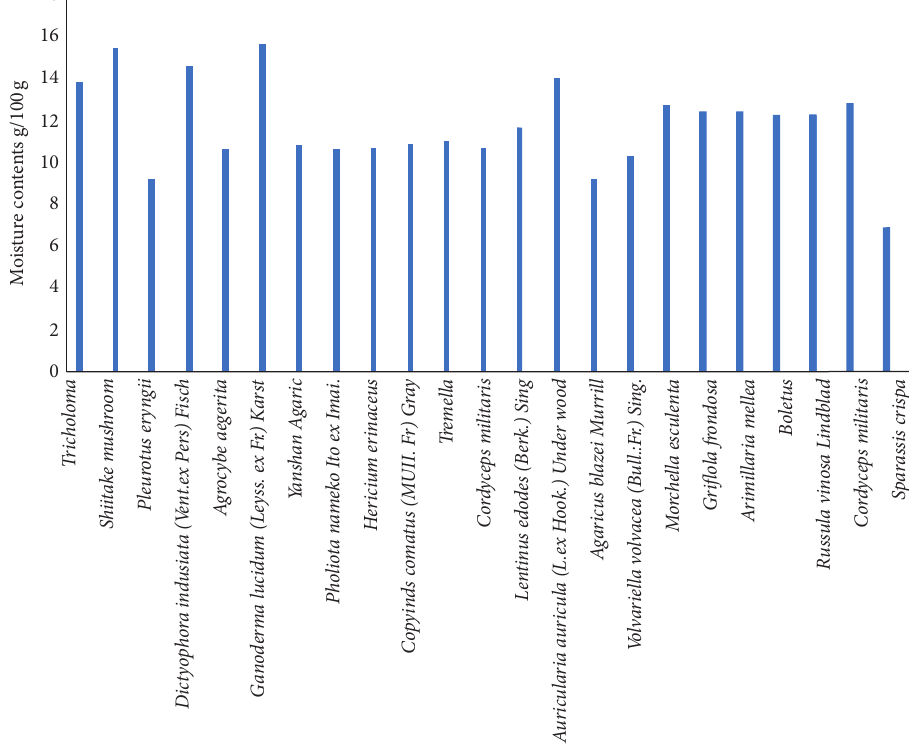
Figure 1: Moisture contents of 23 kinds of edible